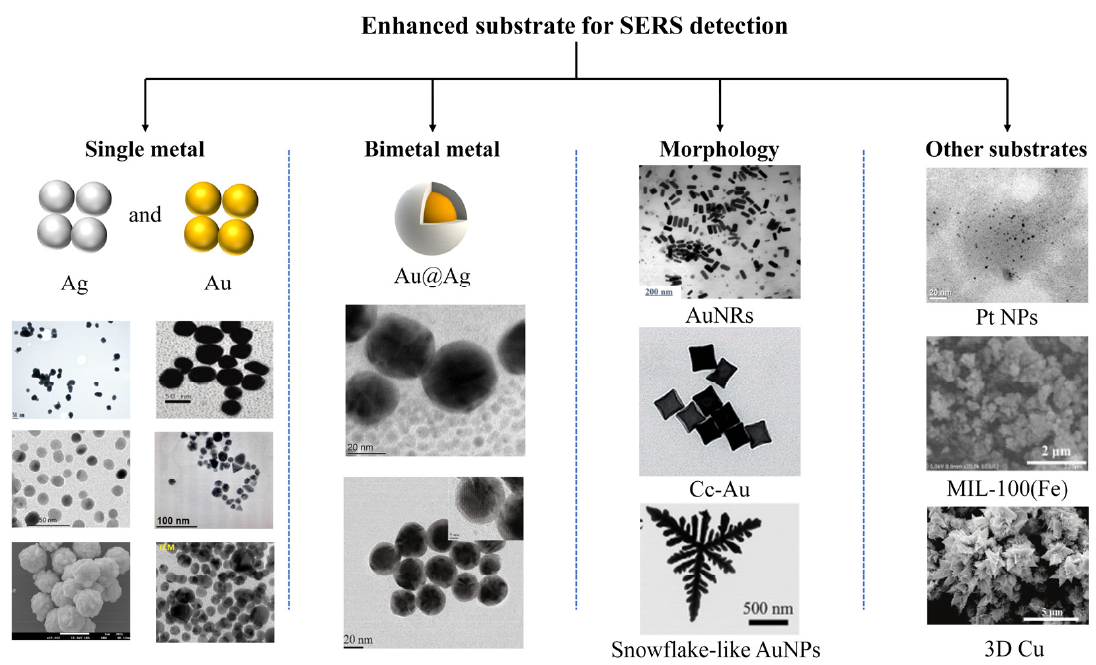
Figure 4. Schematics of various types of substrates used for SERS detection. These substrates with different materials and different morphologies are used to improve SERS performance such as sensitivity, selectivity, reproducibility, and stability (adapted with permission from [78]. Copyright {2009} American Chemical Society).